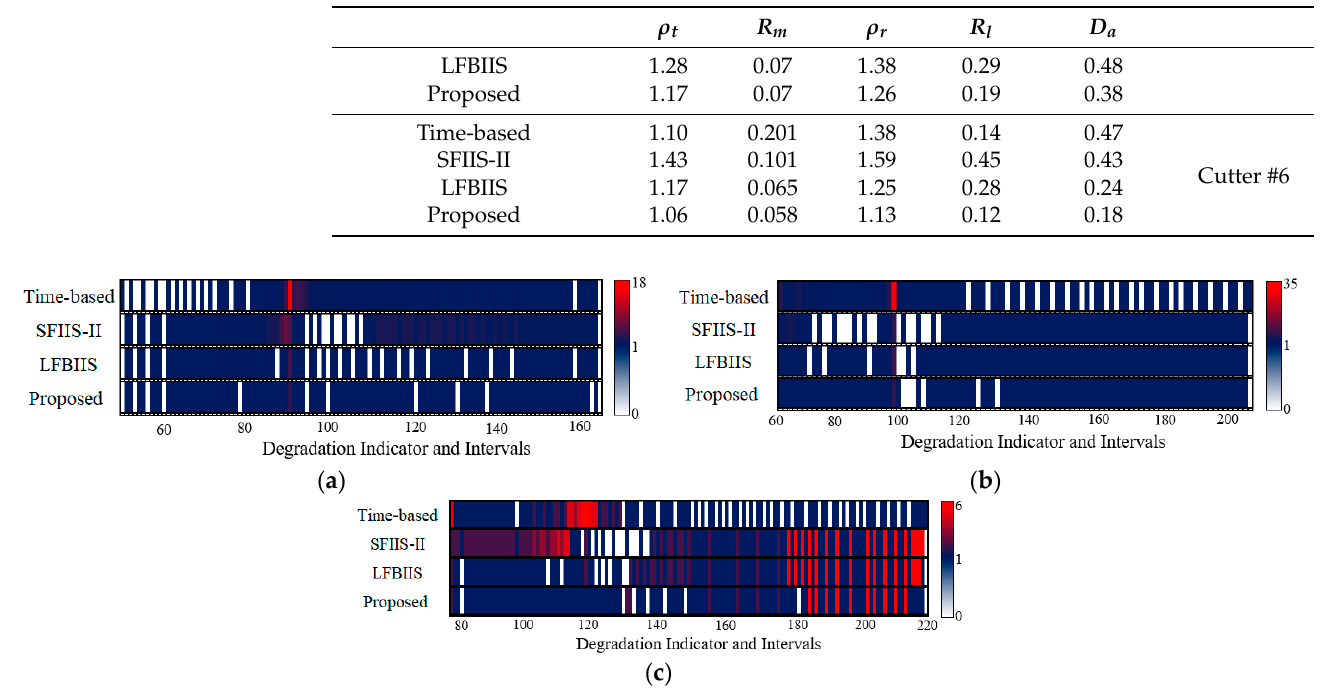
Figure 9. The distribution of sampled data from the PHM2010 dataset. ( a ) Cutter #1; ( b ) Cutter #4; ( c ) Cutter #6. Table 5. Results of performance metrics for the PHM2010 dataset.